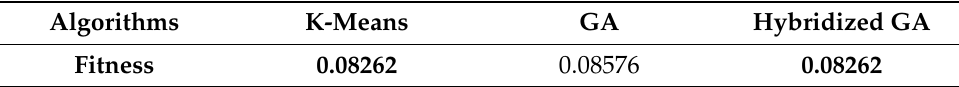
Table 5. Evaluation of K-means, Genetic Algorithm, and hybridized GA for K = 7